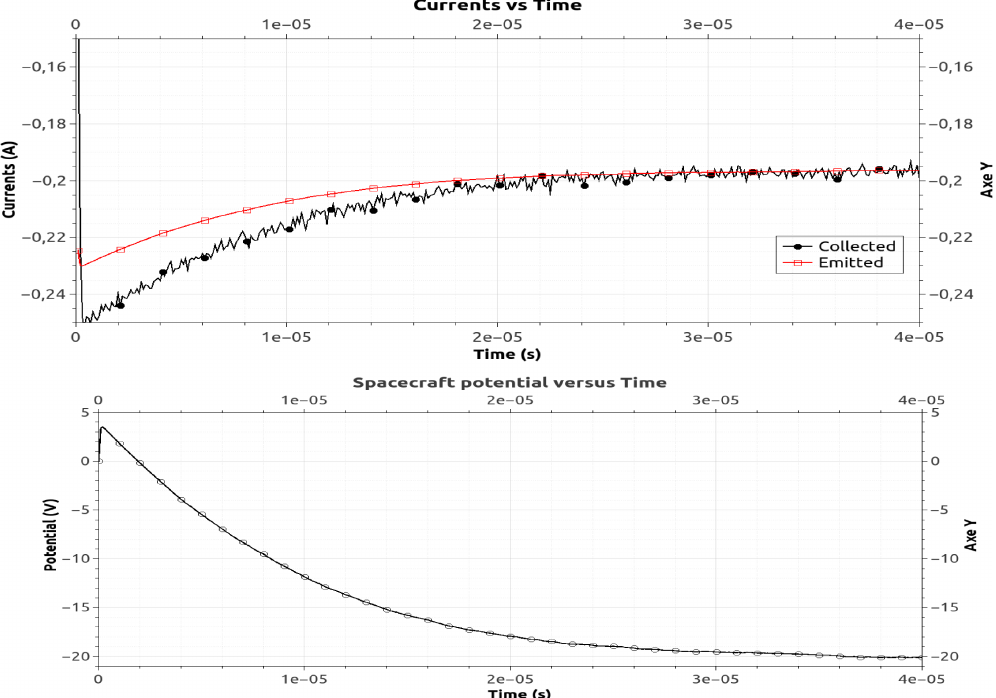
Fig. 4. Cross comparison simulation B (SPIS). Evolution versus time of all collected and emitted currents (on top) and of spacecraft average surface potential (on the bottom).